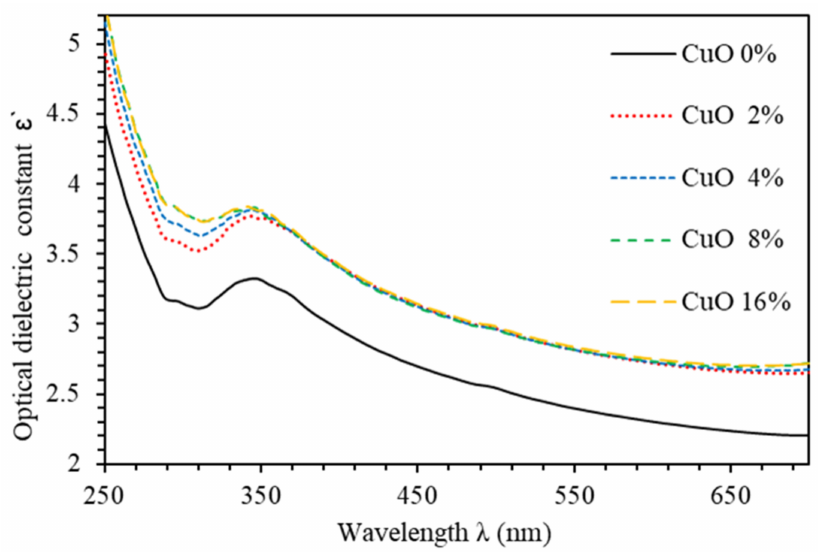
Figure 6. Optical dielectric constant ( ε (cid:48) ) spectra of PMMA–PVA/CuO nanocomposite thin films as a function of wavelength for various CuO NPs concentrations.